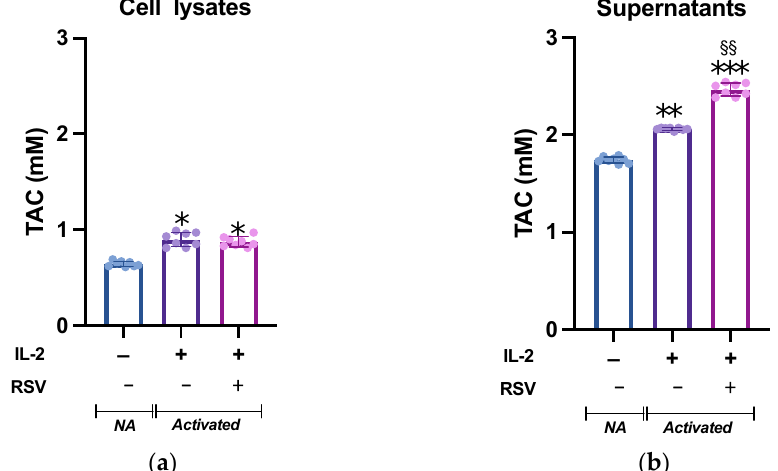
Figure 3. TAC levels in ( a ) lymphocytes and ( b ) supernatants from NA, IL-2-, and IL-2 + RSV- treated cells. Data are expressed as mean ± SD of Trolox equivalents (mM). NA = non-activated. * p < 0.05 vs. NA; ** p < 0.01 vs. NA; *** p < 0.001 vs. NA; §§ p < 0.01 vs. IL-2 only.